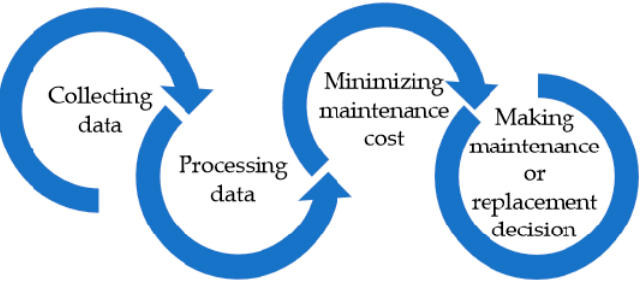
Figure 4. CBM policy(cid:31)s main steps.